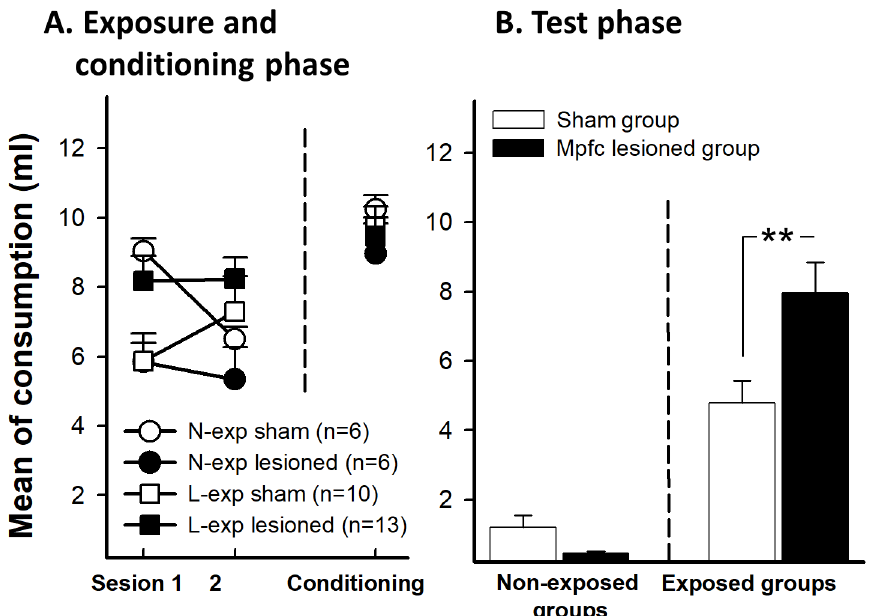
Fig 6. A. As experiment 2, the graph shows the mean saccharin intake duringthe two sessions of preexposure (left) and conditioningphase(right) for sham and mpfc lesionedanimals(L-exp and N-exp). B. Mean of saccharinintake in limited exposure(L-exp) of the future CS in sham and mpfc lesionedgroups. Error bars represent SEMs. Asterisks indicatesp < 0.01.N-exp: non exposedgroups, L-exp: limited exposure